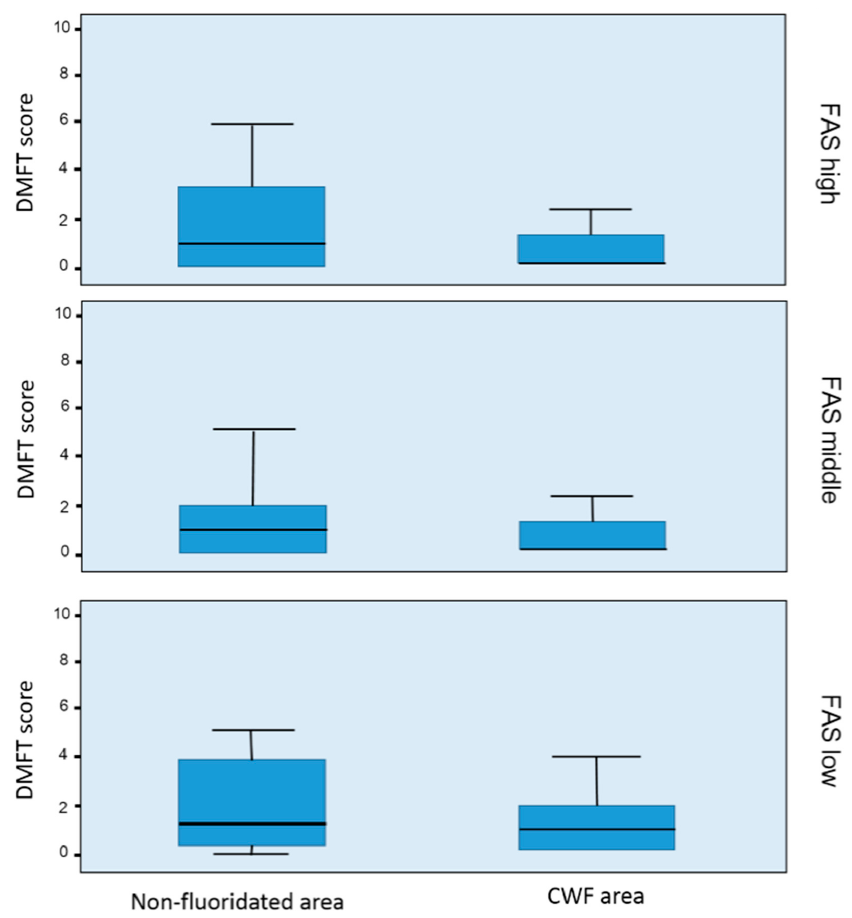
Figure 4. Box plots for the decayed, missing, and filled teeth (DMFT) scores of 11-year-old children based on the Family Affluence Scale (FAS) levels.